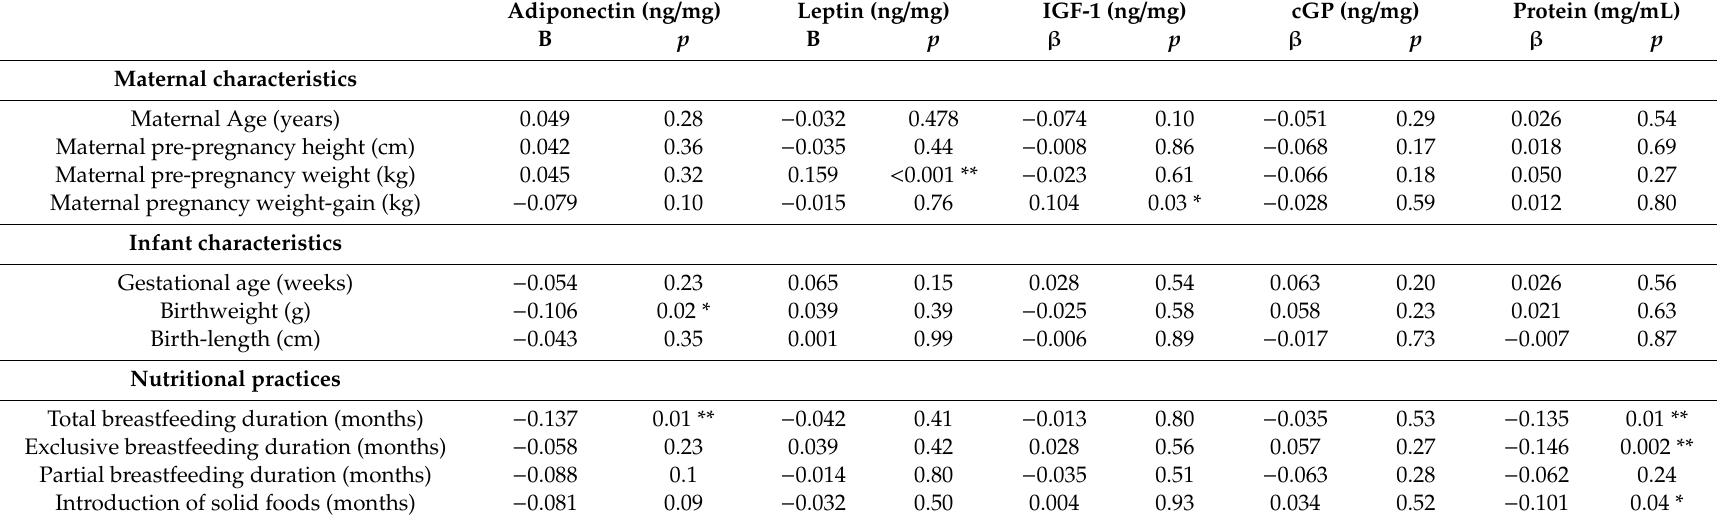
Table 3. Simple linear regression between maternal-infant characteristics and HM adiponectin, leptin, IGF-1, cGP and total protein.